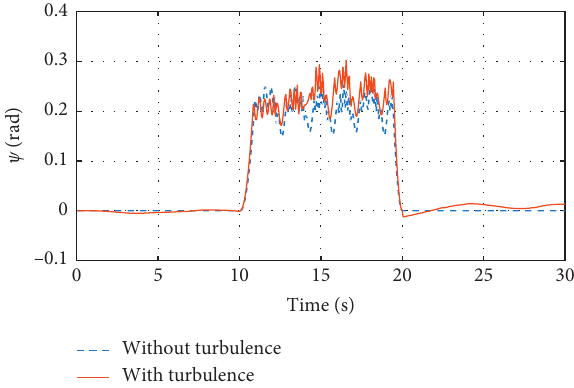
Figure 10: The difference of heading angle with the